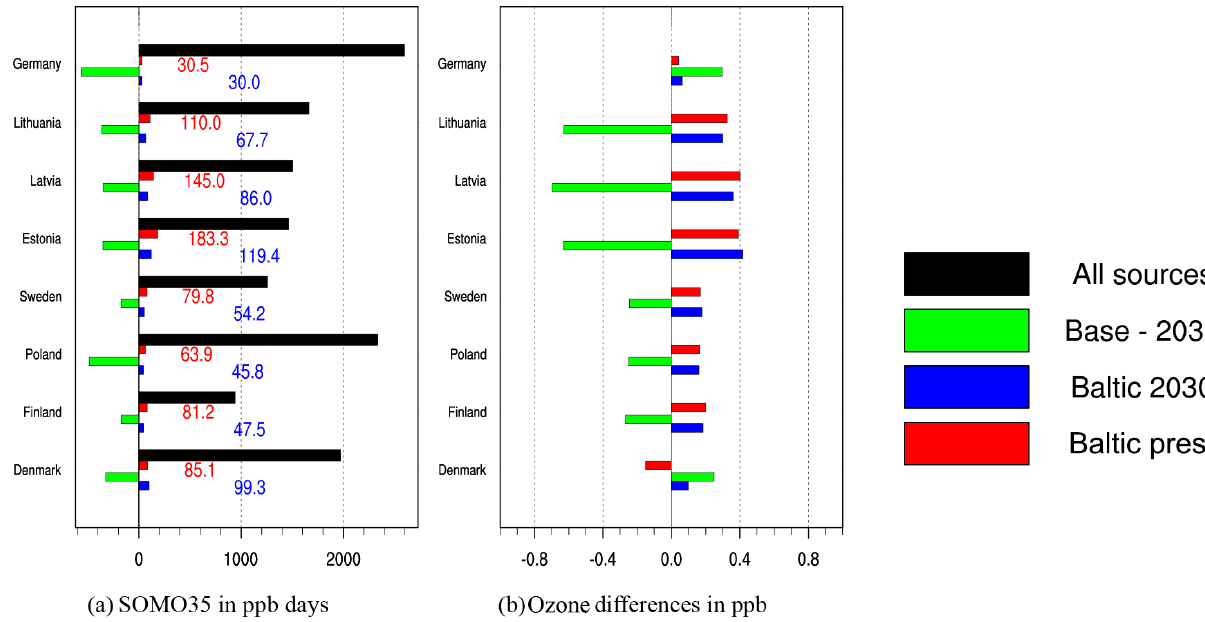
Figure 4. (a) SOMO35 in ppb days where black bars represent Present_Base levels. (b) Changes in annual ozone in ppb (annual average ozone is in the 30–35ppb range in all countries). For both SOMO35 and annual ozone green bars represent changes in levels from 2016 to 2030 (Future_Base–Present_Base), red bars contributions from BAS (Present_Base–Present_NoShip), and blue bars contributions from BAS in 2030